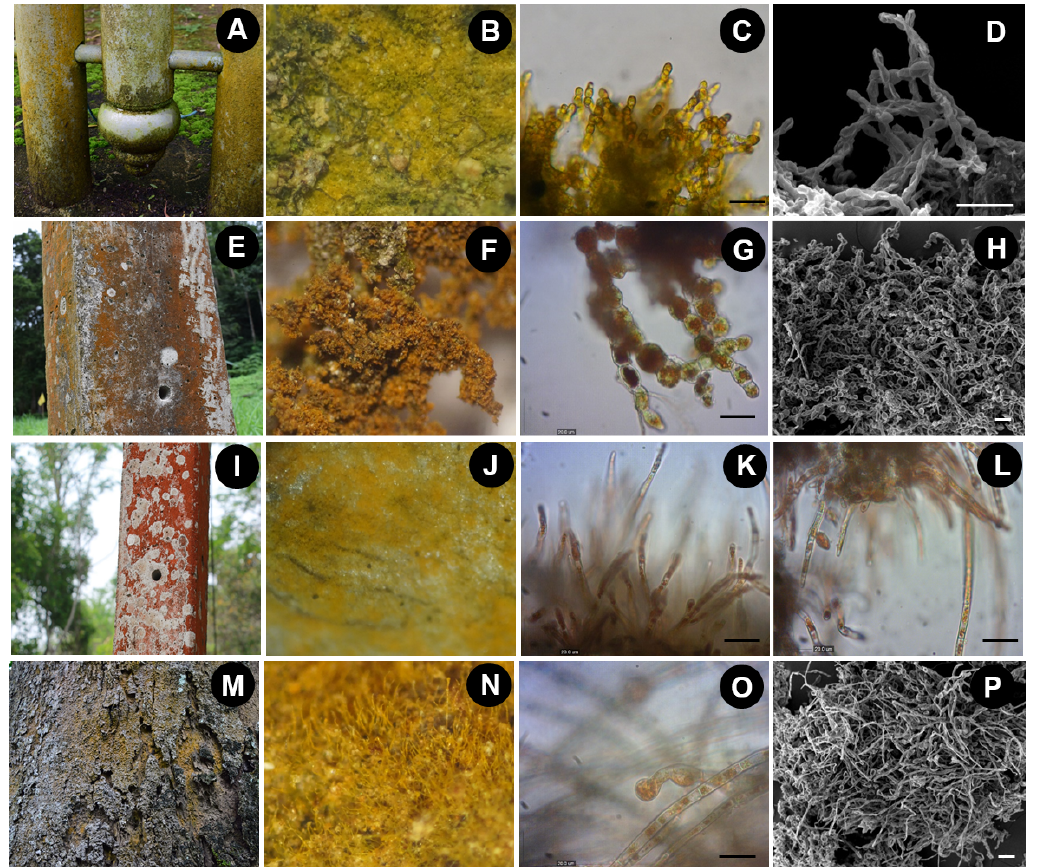
Figure 4 Subaerial green algae genus Trentepohlia at 13 sampling points in the rainy, winter, and summer seasons, including Trentepohlia sp. 3 ( A–D ), T. rigidula ( E–H ), Trentepohlia sp. 4 ( I–L ), and T. effusa ( M–P ). Scale bars: 20 µ